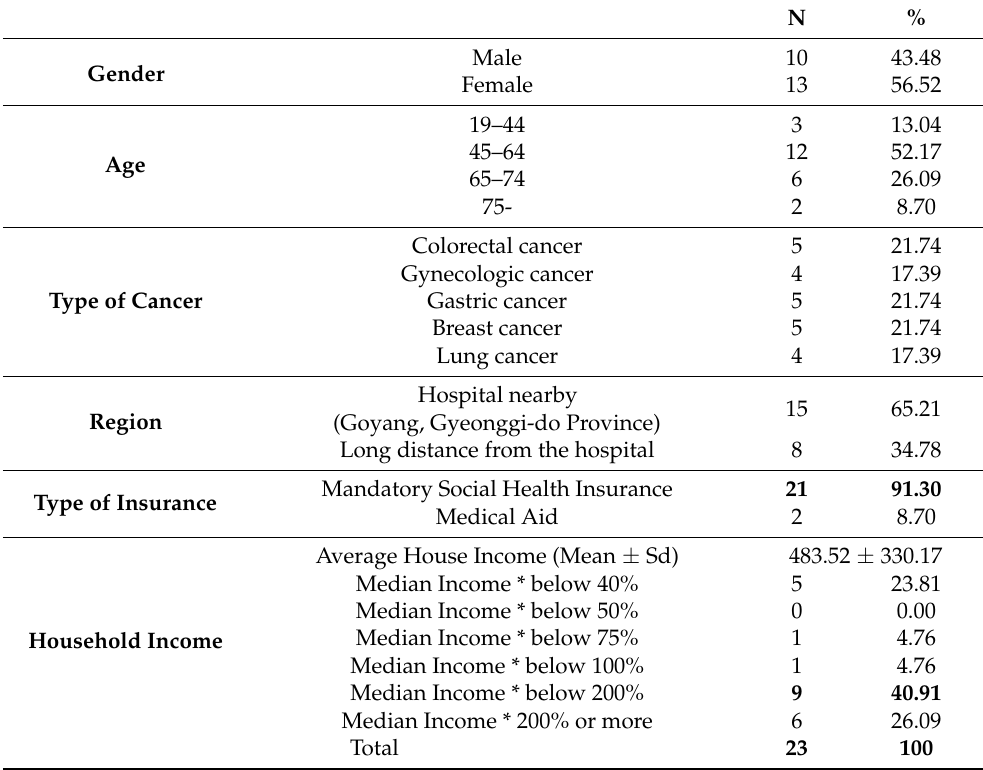
Table 1. Demographics of study